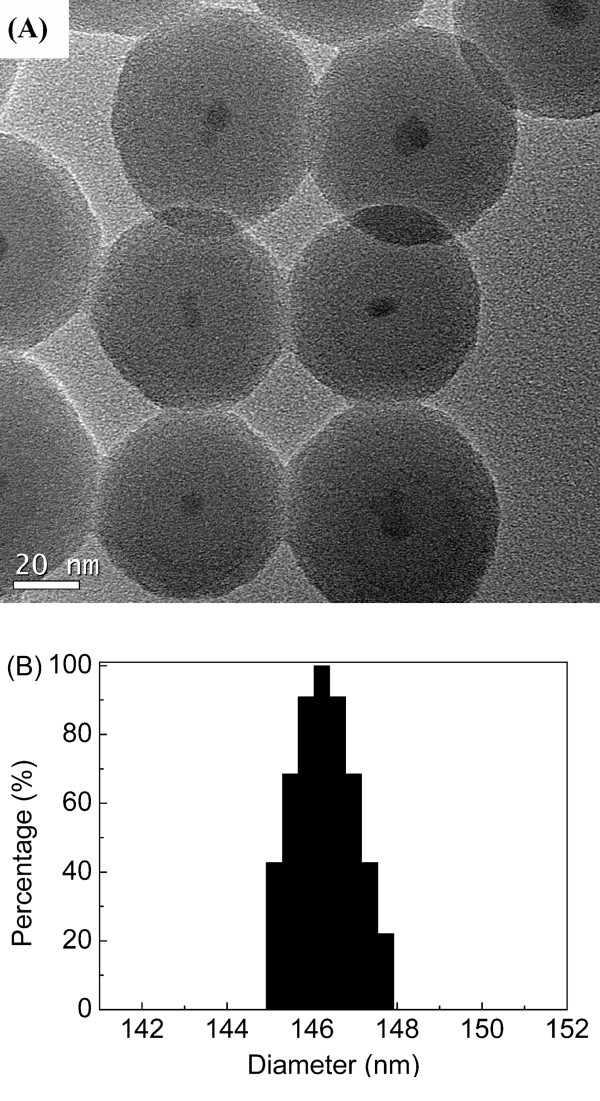
TEM image (A) and the particle size histogram from DLS (B) of DTH-Fe3O4@SiO2.